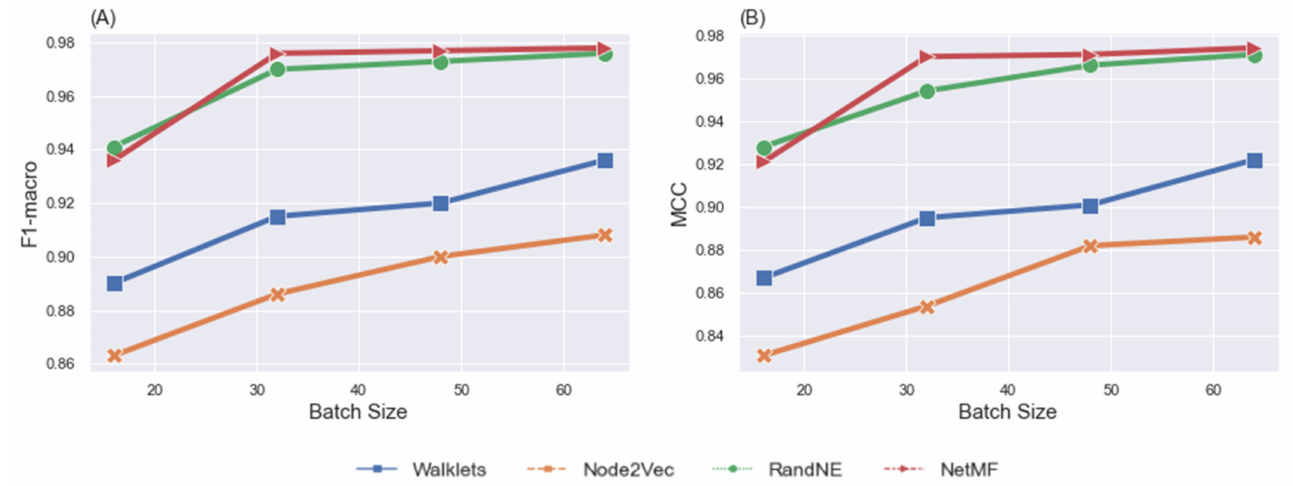
Figure 2. F1 macro ( A ) and MCC ( B ) comparison of the GCN model, taking into account the influence of node embedding methods and batch sizes for the task fMRI classification task, by using the 302 participants’ fMRI data.